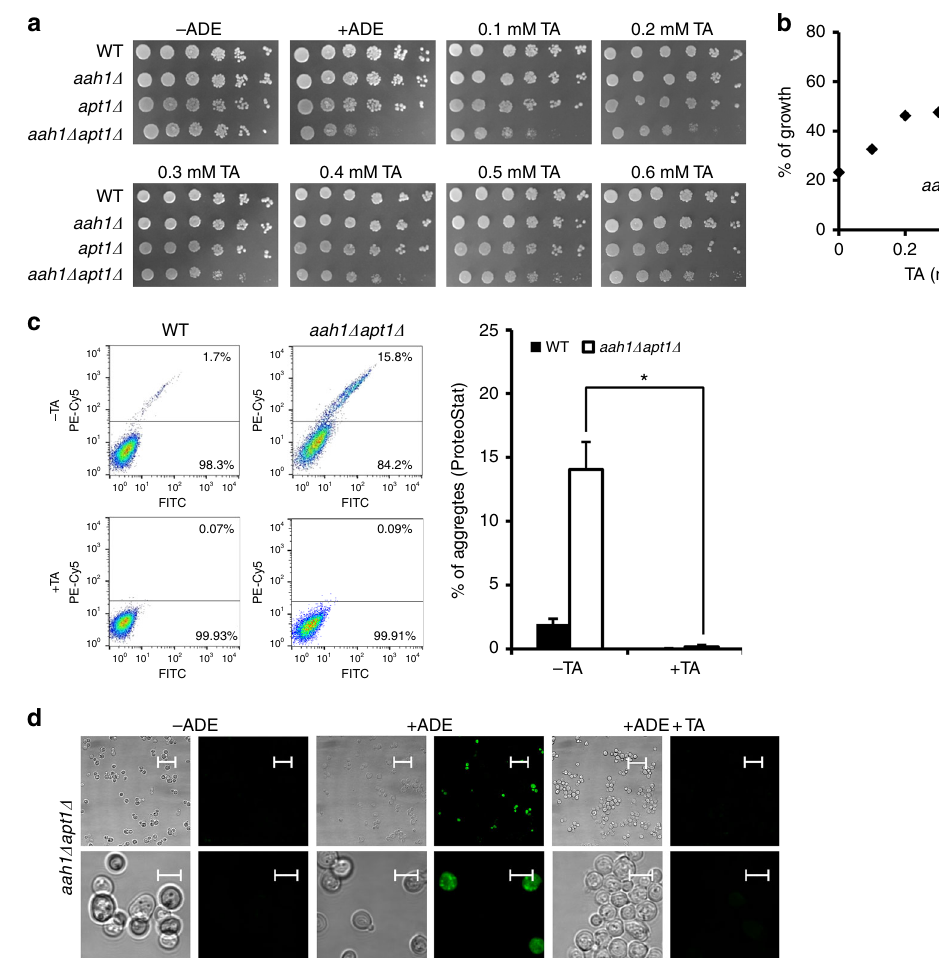
Fig. 4 Addition of TA rescues the toxic effect observed in the adenine salvage mutant. a WT, aah1 Δ , apt1 Δ , and aah1 Δ apt1 Δ strains were serially diluted and spotted on SD medium without adenine ( − ADE) or on SD media containing 2 mg/L adenine with or without various concentrations of TA, as indicated. b Dose – response curve for aah1 Δ apt1 Δ cells in SD medium containing adenine and TA at different concentrations. The percentage of growth represents the growth with TA compared to the growth without TA. c Flow cytometry analysis of WT and aah1 Δ apt1 Δ cells under the indicated conditions following ProteoStat staining. * P < 0.01 (Student ’ s t -test). Values are the mean ± s.d. of three experiments. TA concentration was 0.5 mM. d Representative confocal microcopy images of aah1 Δ apt1 Δ cells under the same conditions as in ( c ). Cells were visualized using DIC microscopy. Scale bars are 50 and 5 μ m for the lower ( fi rst line) and higher resolution (second line)